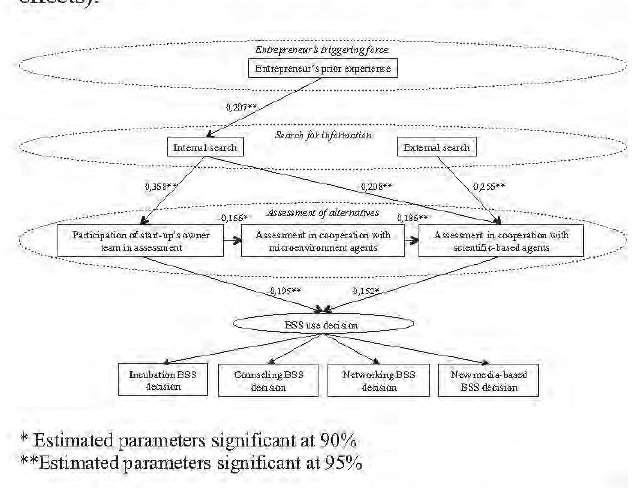
Figure 3: Parameter estimates for the analytical model Since the path parameter linking previous